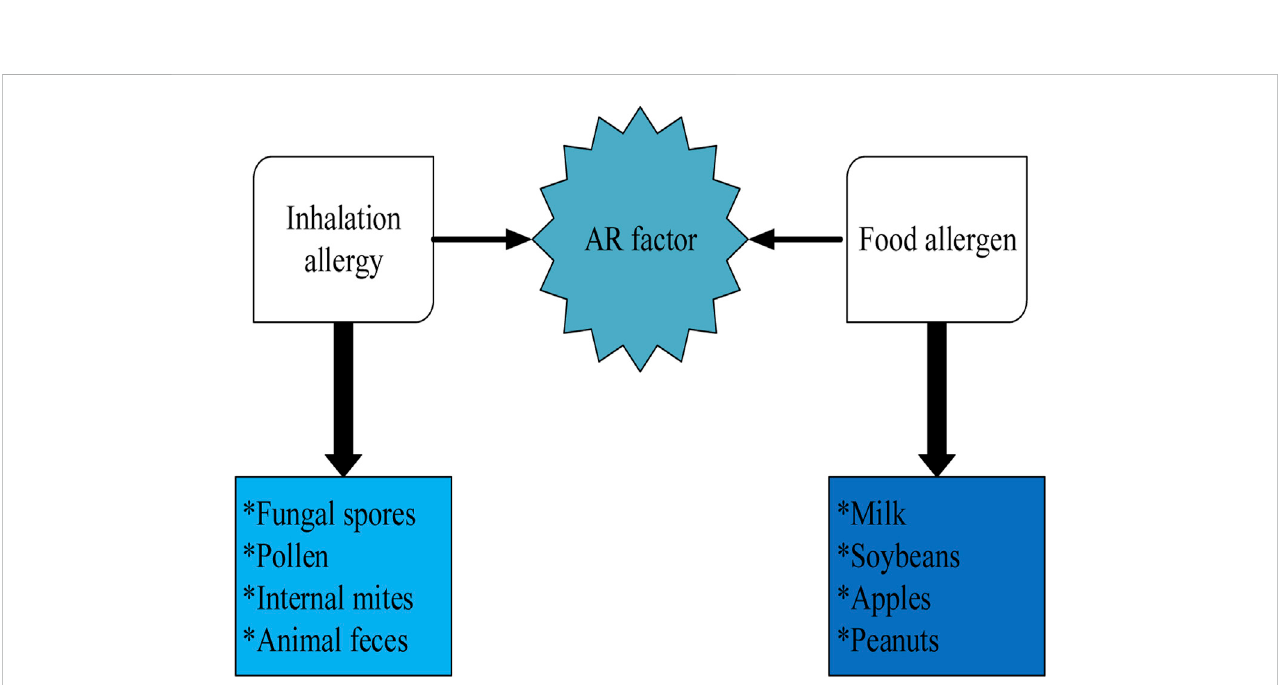
FIGURE 2 Inducement factors of